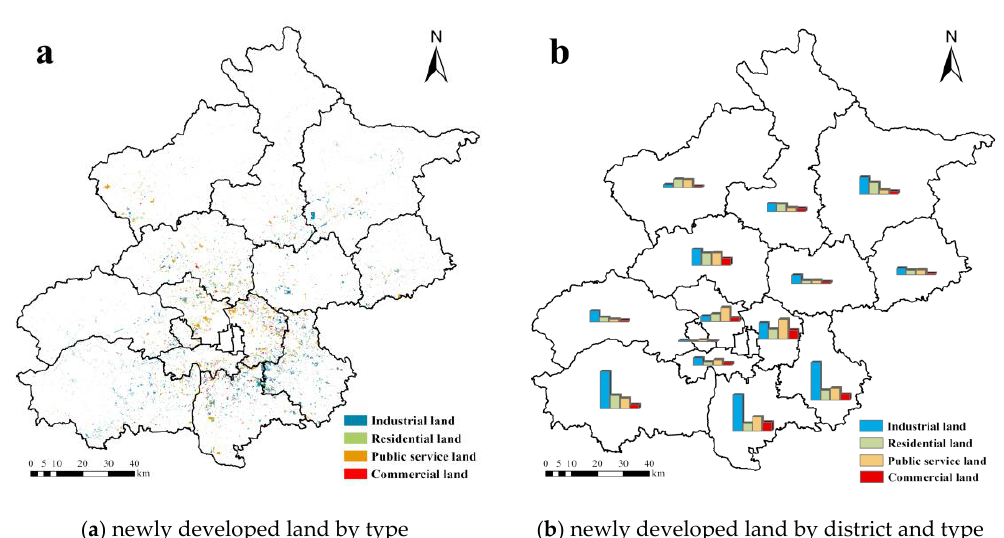
Figure 4. Distribution of the four types of newly added construction land in Beijing from 2001 to 2010.